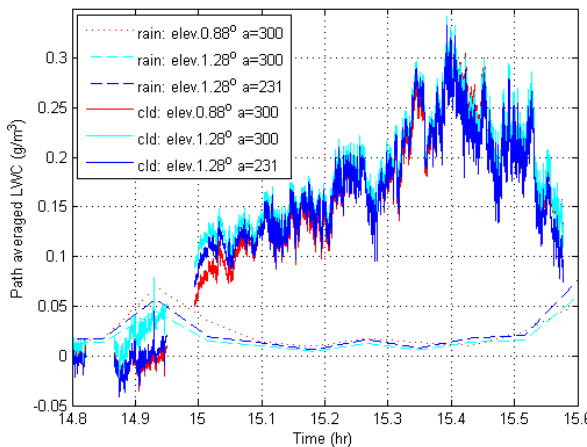
Fig. 18. Estimated average liquid water content in the rain and clouds along the 5.4km path between the